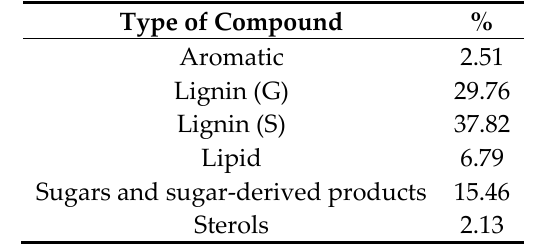
Table 3. Released gases of SRCP at optimal temperature from Py-GC/MS as percentage of total chromatographic